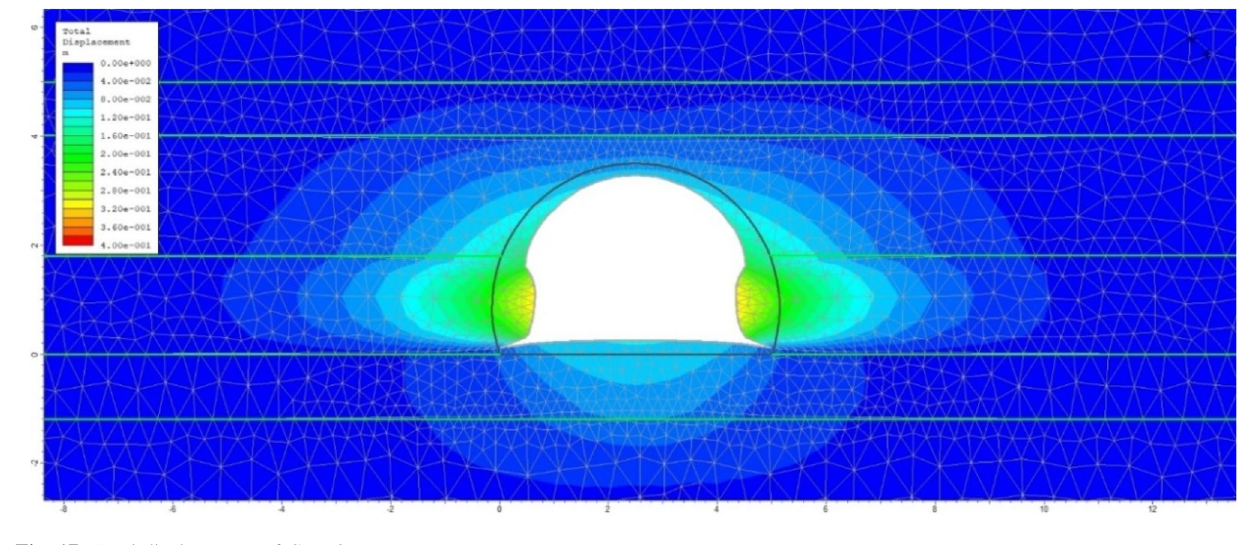
Fig. 17 Total displacement of Case 3